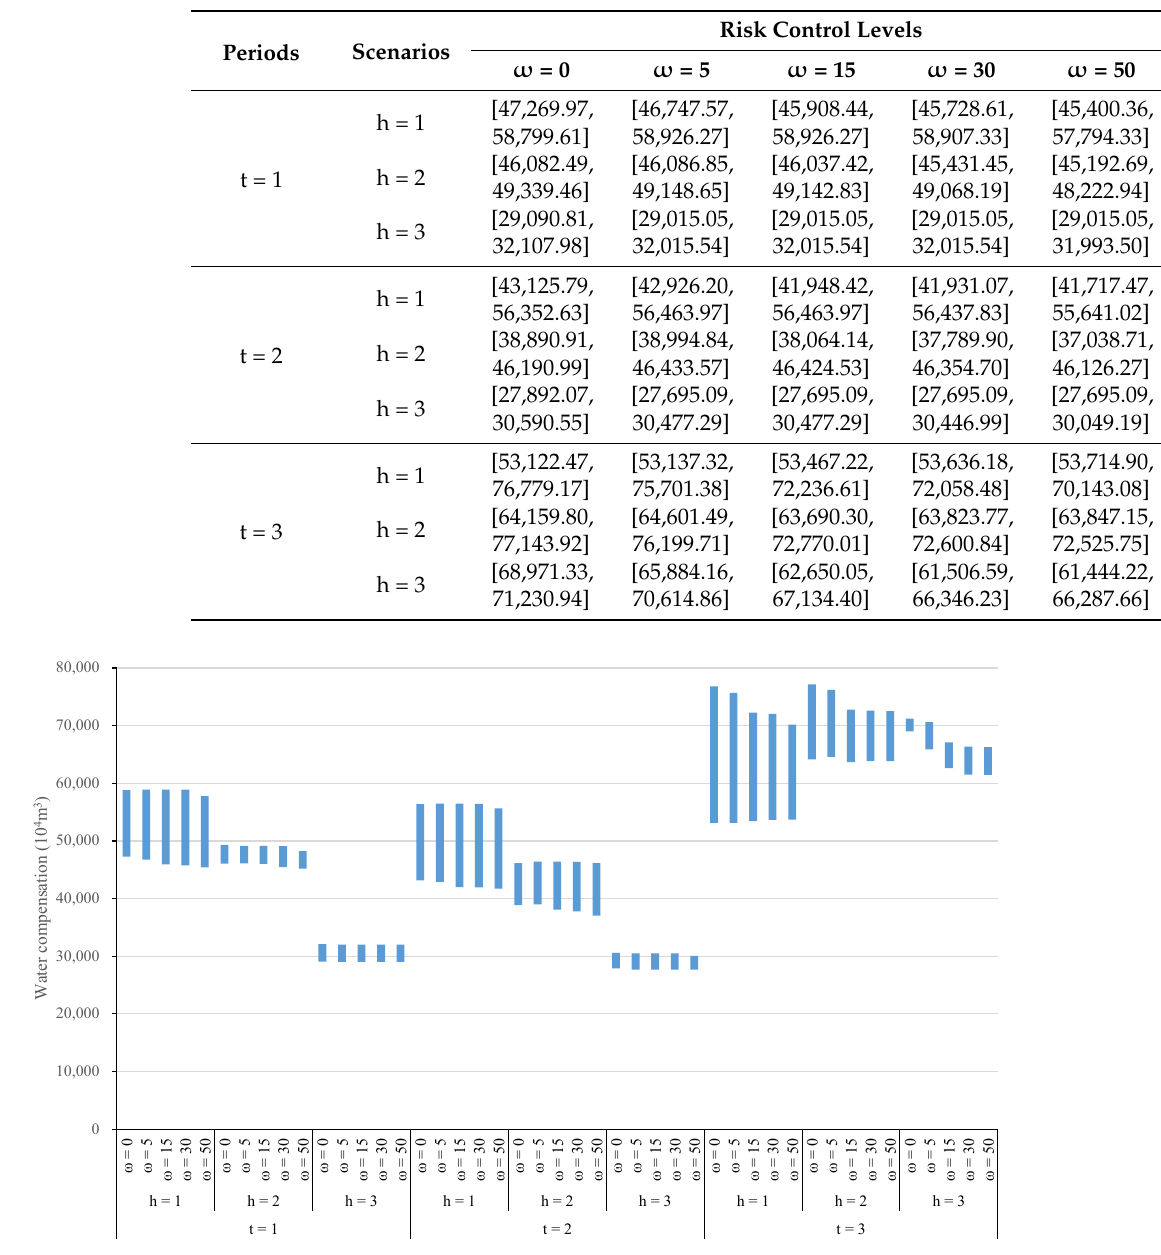
Risk Control Levels